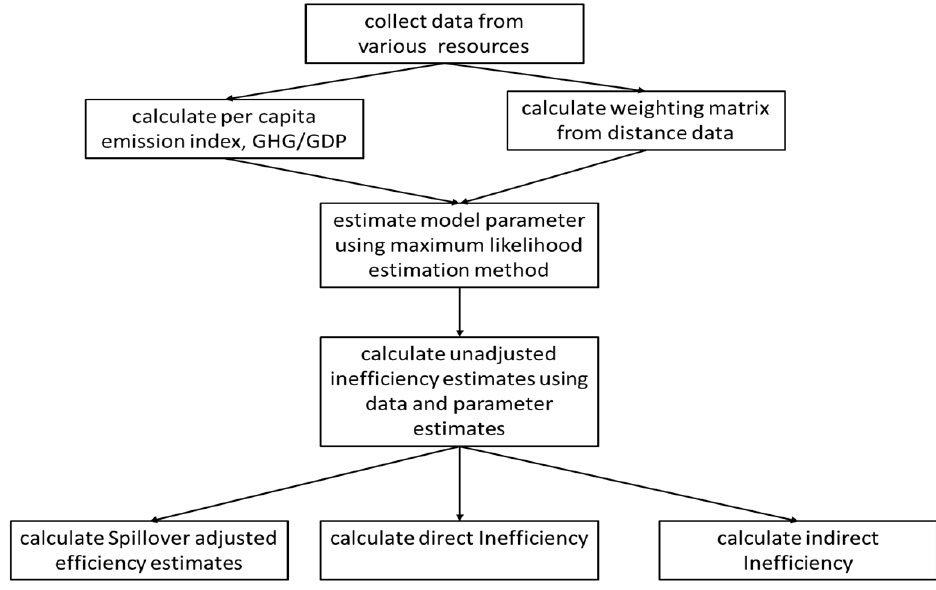
Figure 1. Model Flow Chart.